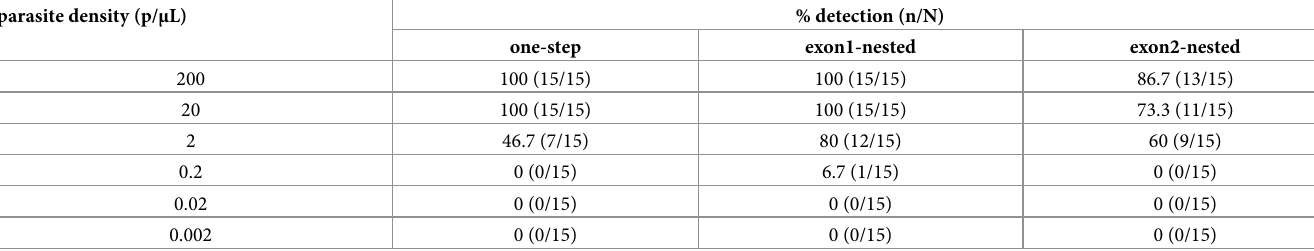
Table 2. Analytical sensitivity of PCR methods against titrated cultured parasites. parasite density (p/ μ